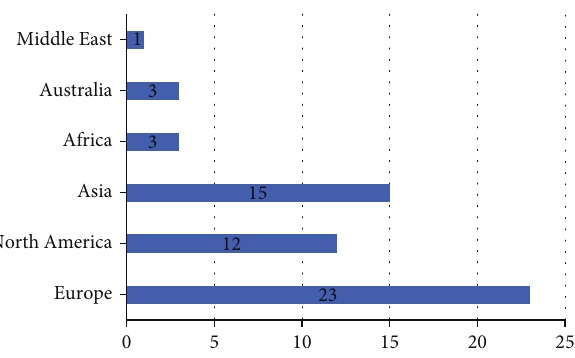
Figure 6: Number of papers as per